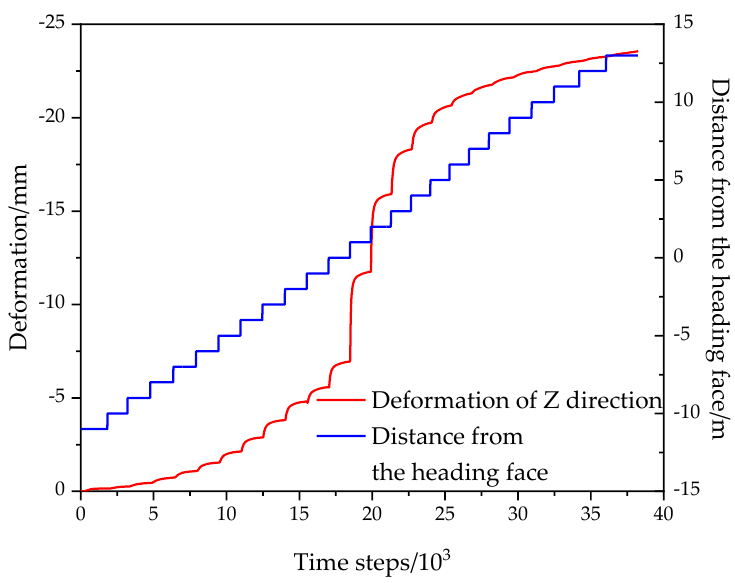
Figure 9. Relationship between roof displacement and heading face position.